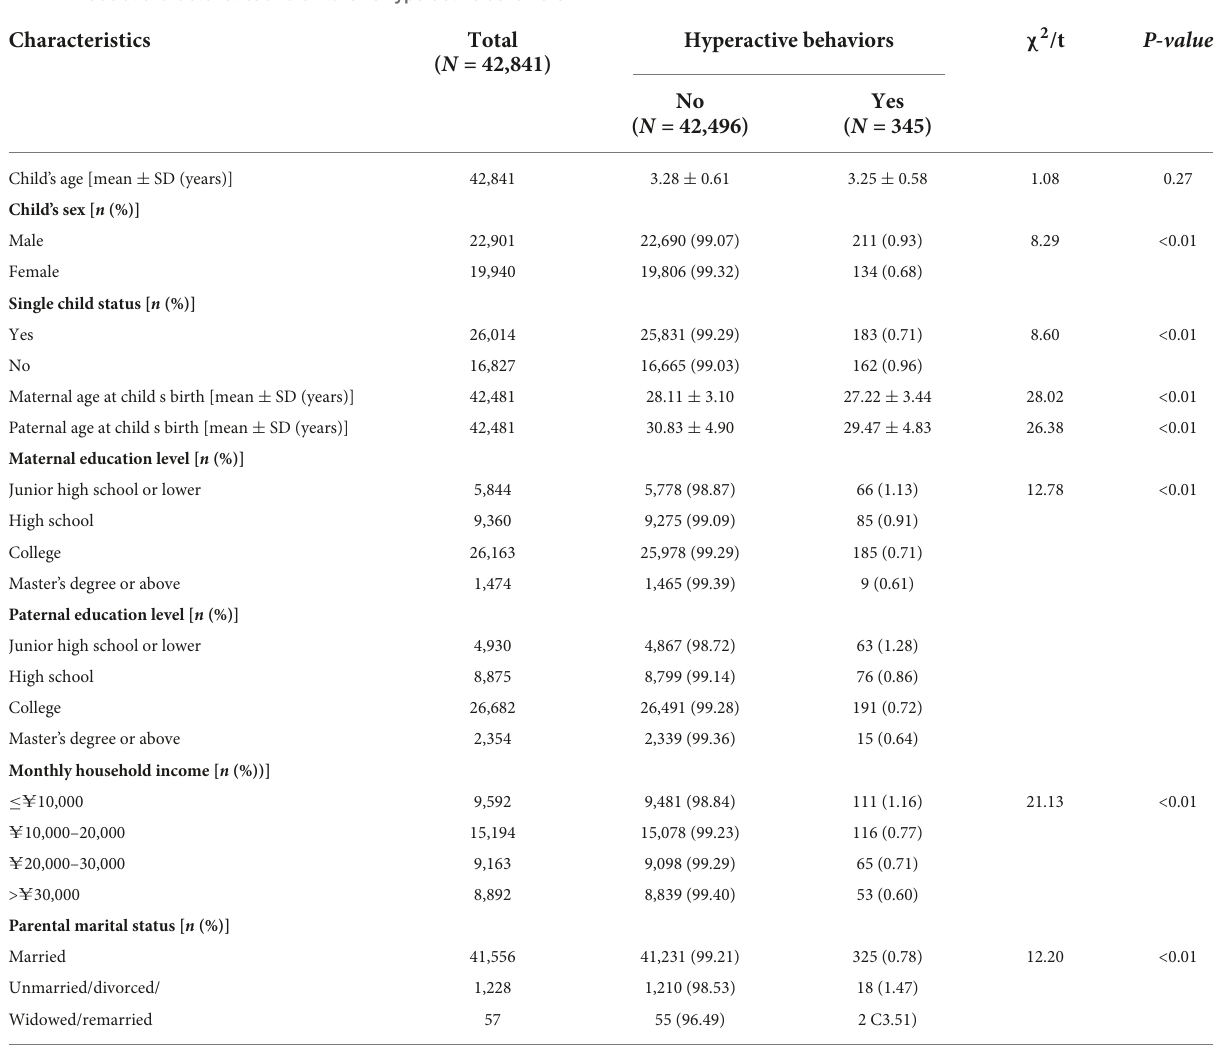
TABLE 2 Social characteristics and children’s hyperactive behaviors.